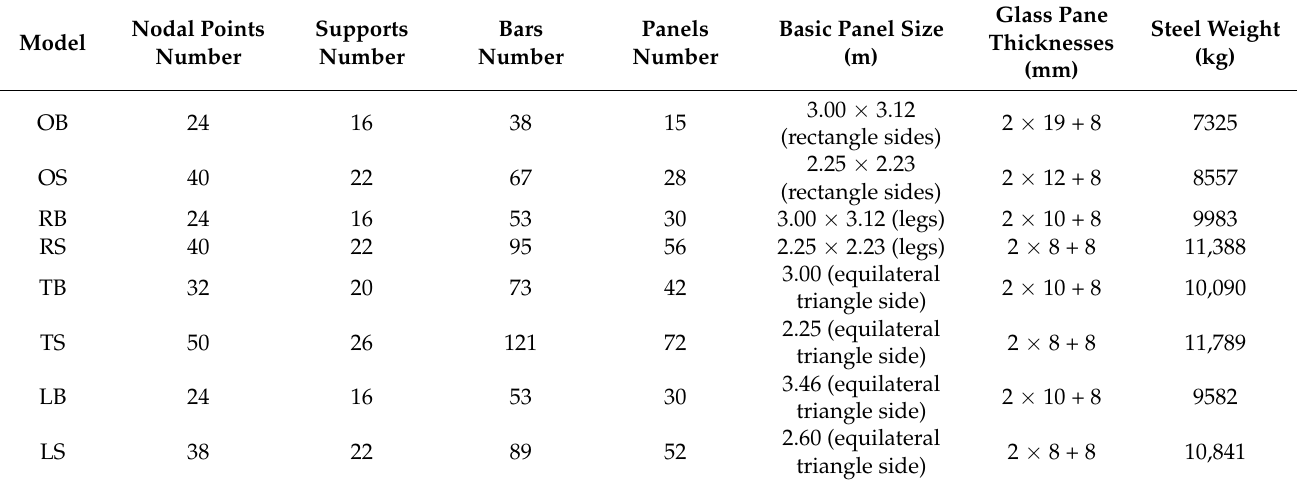
Table 6. Properties of the